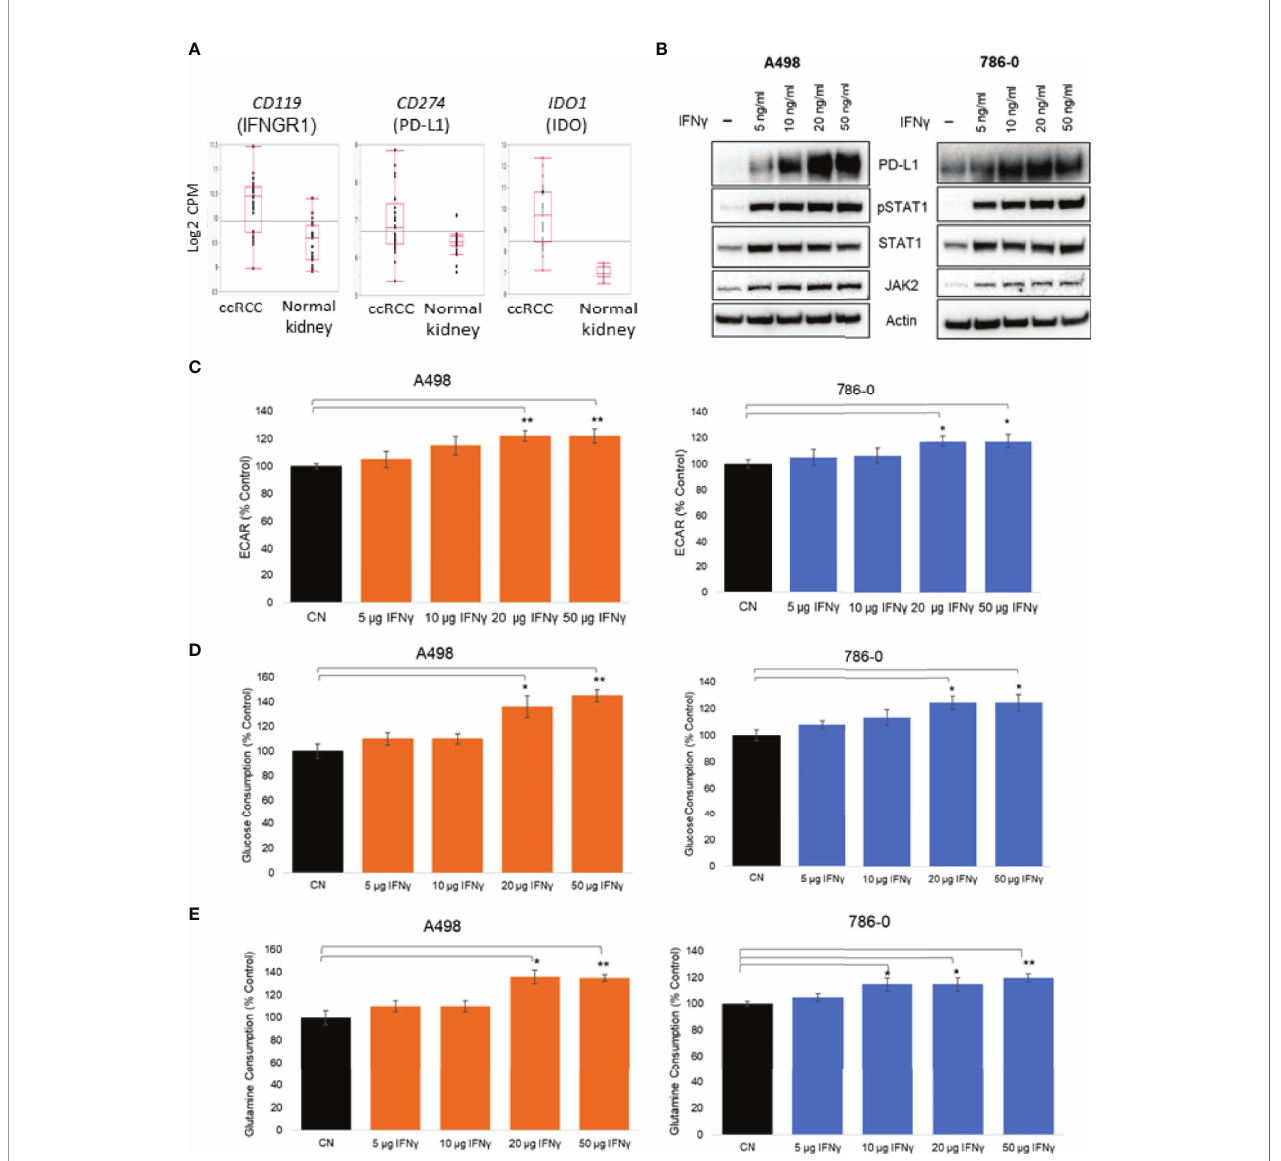
FIGURE 1 | Effect of IFN g treatment on A498 and 786-O ccRCC cells metabolism. (A) Expression of CD119 , CD274 and IDO1 in ccRCC compared to normal kidney; (B) Representative immunoblot of PD-L1, PD-L2, JAK2 and pSTAT1 in A498 and 786-O cells treated with IFN g (5, 10, 20 and 50 ng/mL) for 24 hours; (C) A surrogate for lactate secretion (extra cellular acidi fi cation rates, ECAR) and oxygen consumption rates (OCR) were measured using a bioanalyzer following IFN g treatment (5, 10, 20 and 50 ng/mL for 24 hours) in A498 and 786-O cells; Glucose (D) and glutamine (E) consumptions were measured following IFN g treatment (5, 10, 20 and 50 ng/mL for 24 hours)The data are presented as mean ± SD (n=3) *p<0.05;